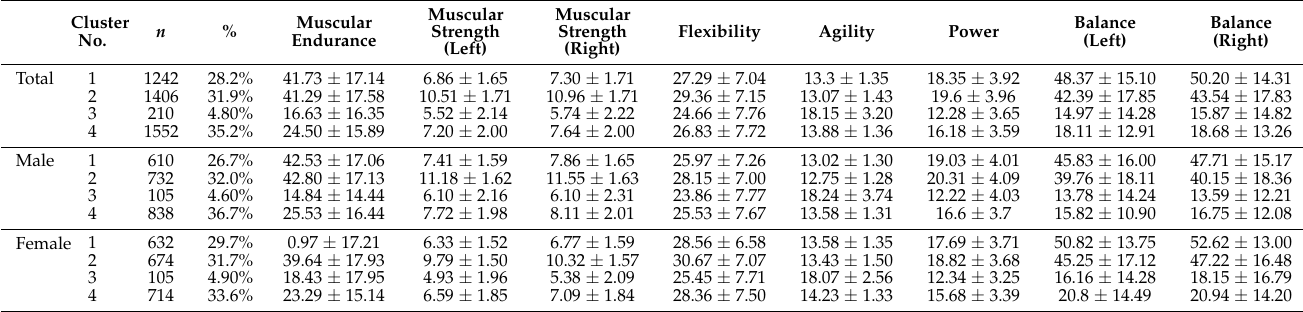
the eight physical fitness factors (muscular endurance, muscular strength (left, right), flexibility, agility, power, balance (left, right)) are shown in Table 1. Cluster 4 was the highest proportion among the clusters with 35.2% of all case, followed by cluster 2 with 31.9% of all case, cluster 1 with 28.2% of all case, and cluster 3 with 4.8% of all case (Table 1). Table 1. Performance statistics on eight physical fitness